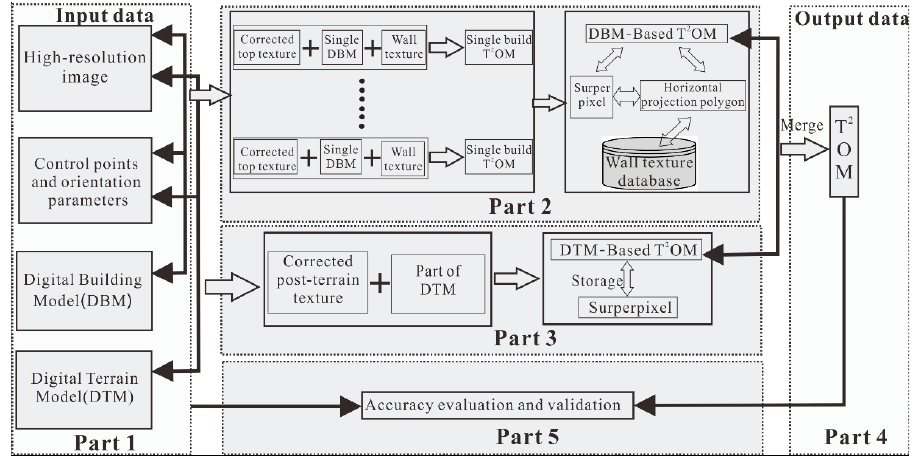
Figure 9. The proposed flowchart for T 2 OM generation.